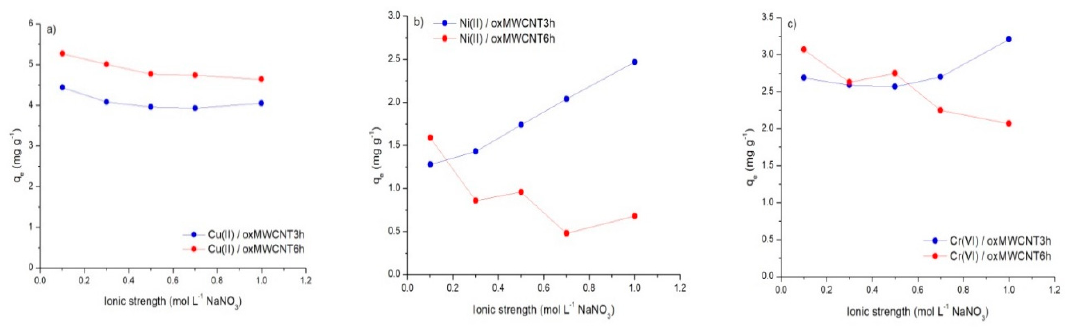
Figure 9. Adsorption of: ( a ) Cu(II), ( b ) Ni(II) and ( c ) Cr(VI) on oxMWCNT3h and oxMWCNT6h as a function of ionic strength ( m = 5 mg, V = 30 mL (0.1–1 M NaNO 3 ), C 0 = 1 mg L − 1 , pH = 5 ± 0.1 (Cu(II) and Ni(II)) and 2.5 ± 0.1 (Cr(VI)), t = 24 h (Cu(II) and Ni(II)) and 96 h (Cr(VI)), agitation speed = 180